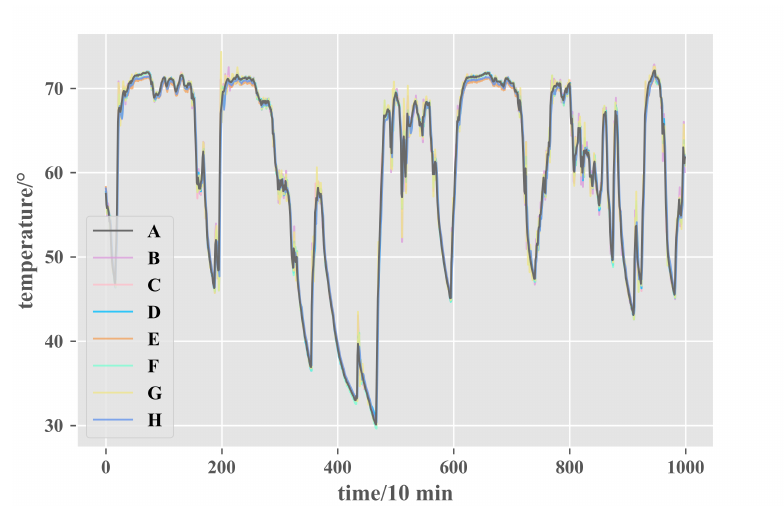
Figure 10. The comparison of different models for gearbox input shaft temperature prediction in #2.